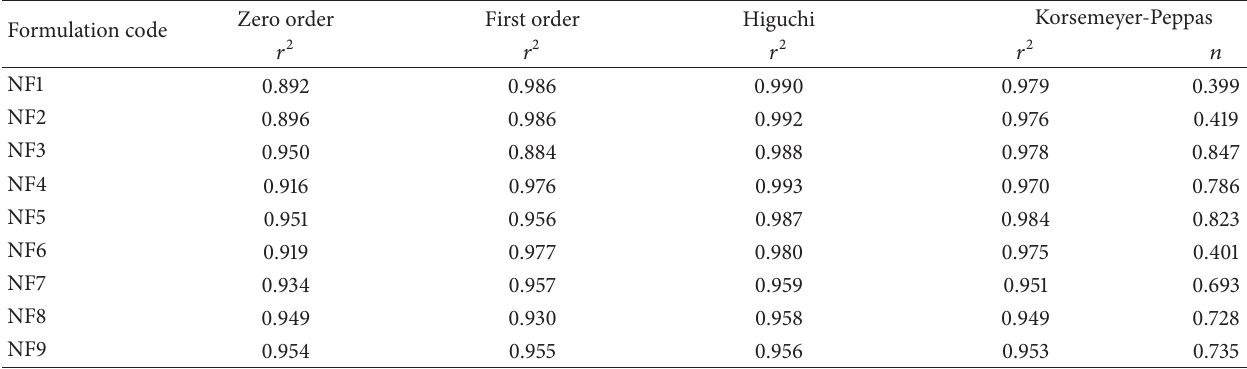
Figure 7: Scanning electron microscopy of optimized batch (NF4), obtained before dissolution (a), after 2h dissolution at pH 1.2 (b), after 5h dissolution at pH 6.8 (c), and during dissolution study at pH 7.4 (d). Table 4: Regression coefficient ( 𝑟 2 ) values of drug release data calculated from various drug release kinetic models and 𝑛 value in accordance with